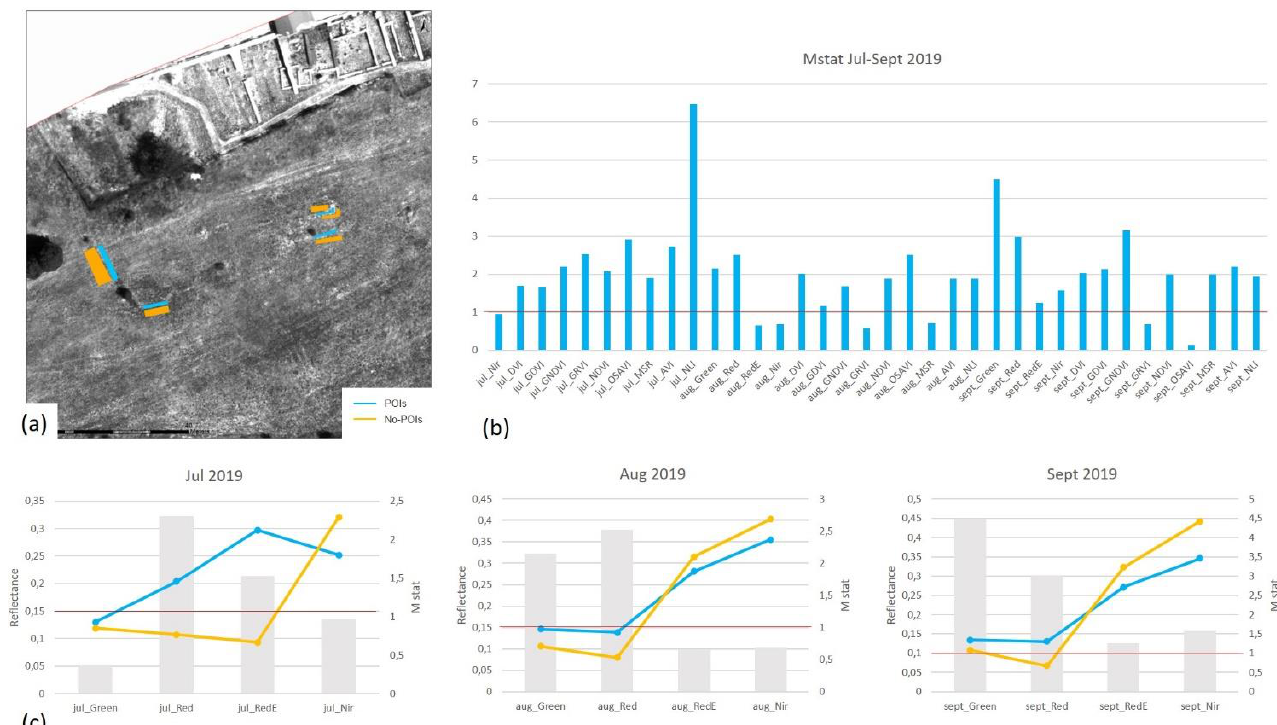
Figure 10. In the graphs, the lines represent the reflectance, referring to ( a ), while the columns represent the statistical M value: ( a ) points of interest selected for the reflectance calculation: (POIs) selection, where the presence of archaeological remains is expected, and points of no interest (No-POIs), where the presence of archaeological remains is not expected; ( b ) M-statistic of the individual bands and of the calculated indices, with reference to the threshold of value 1 used to filter the bands for the SPCA calculation; ( c ) example of the reflectance (left-vertical axis) and statistical M (right-vertical axis) for Green, Red, Red-Edge, and NIR from the July to September acquisitions, with reference to the threshold of value 1 used to filter the bands for the SPCA calculation.